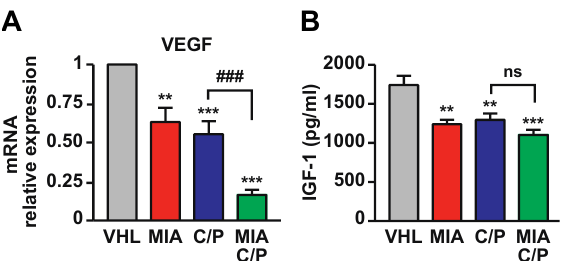
Figure 5. Inhibitory effect of MIA-690 in combination with cisplatin and pemetrexed on expression of VEGF and IGF-1 in PM xenografts. ( A ) VEGF mRNA levels assessed by real-time PCR and normalized to 18S rRNA. Results are means ± SEM. ** p < 0.01, *** p < 0.001 vs. VHL; ### p < 0.001 by one-way ANOVA and Tukey’s post hoc test ( n = 7 for each group). ( B ) Tumor IGF-1 protein levels measured by ELISA. Results are means ± SEM. ** p < 0.01, *** p < 0.001 vs. VHL; ns, not significant ( n = 8 for each group).